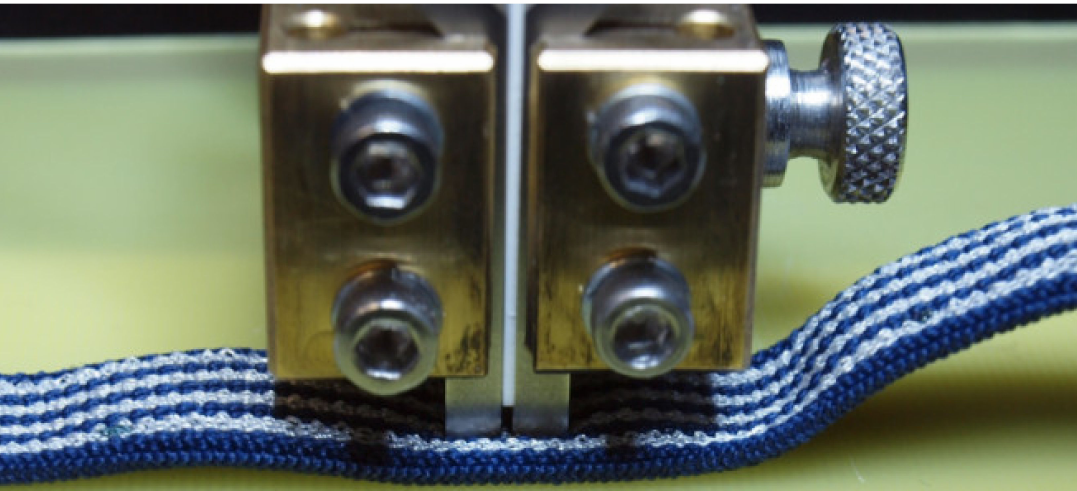
Figure 2. Details of trace interruption by electric